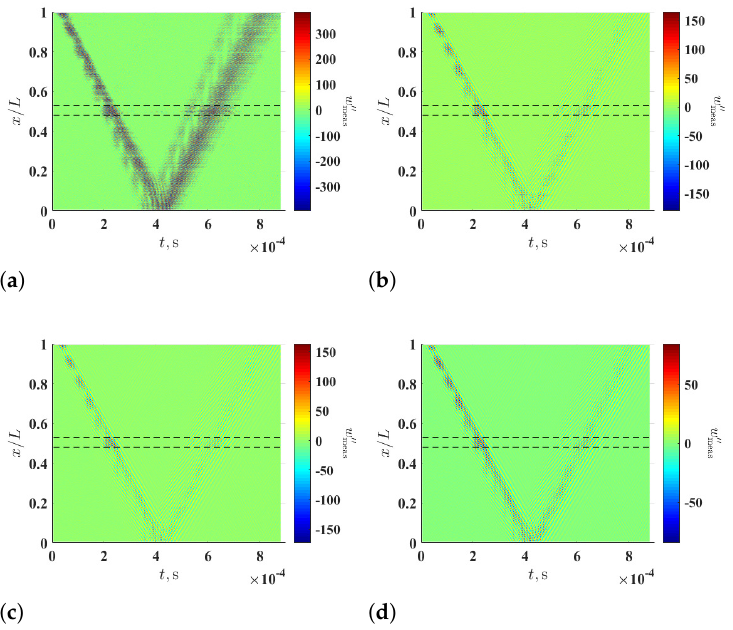
Figure 8. Multi-resolution curvature waveforms associated with the measured wave of the damaged beam with ( a ) r = 1, ( b ) r = 8, ( c ) r = 16 and ( d ) r = 32. Locality and extent of the damage are indicated by two dashed lines.